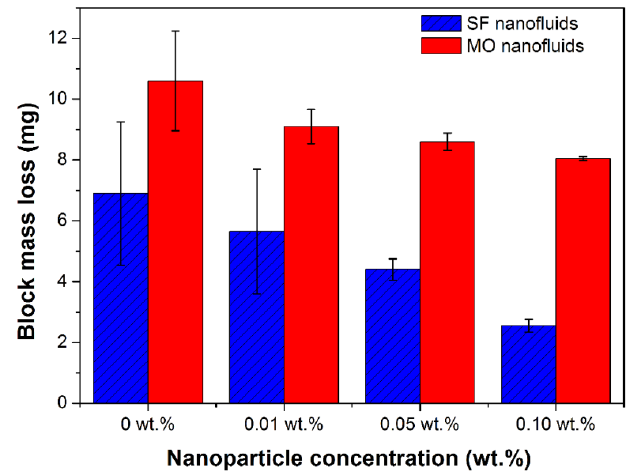
Figure 4. Block mass loss for SF and MO nanofluids with varying concentrations of HNTs.